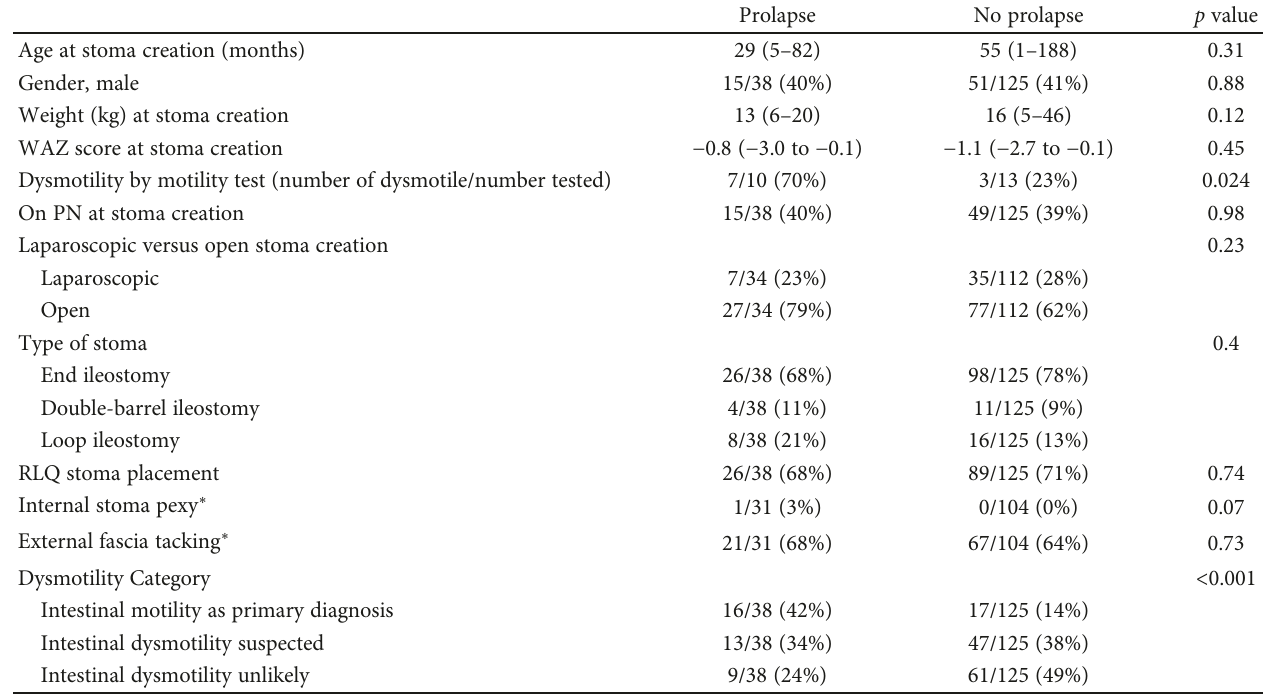
Table 3: Descriptive and clinical variables for patients who did and did not experience pathological ileostomy